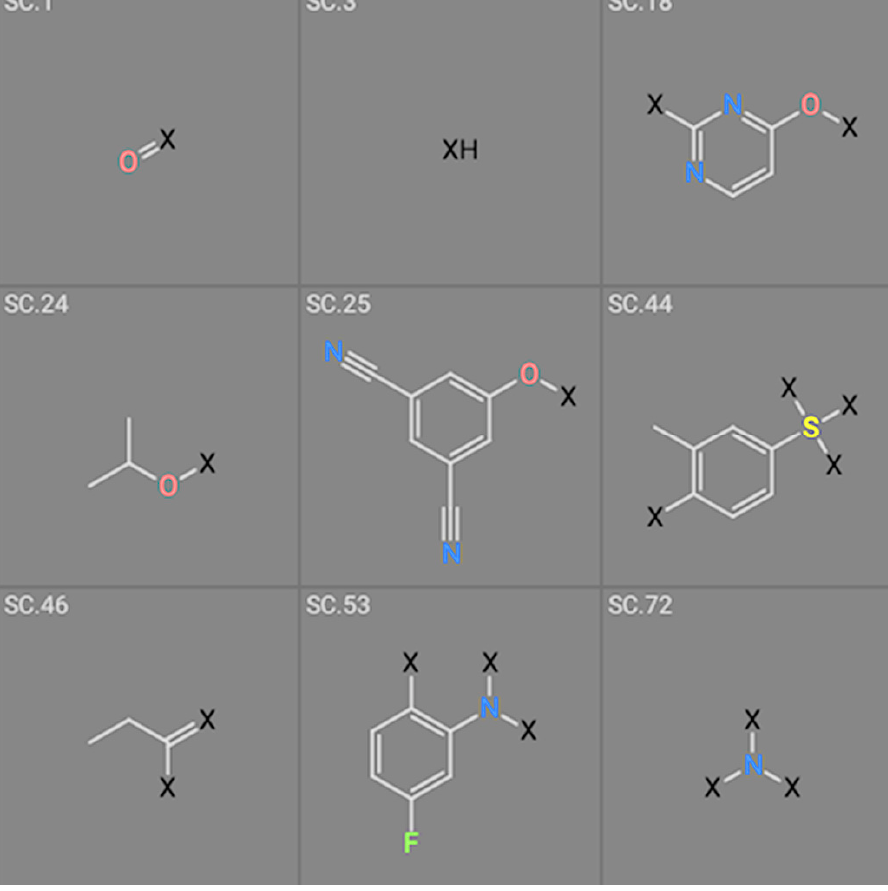
Table 4. Weight vector normalized coefficients of the substructure-based QSAR